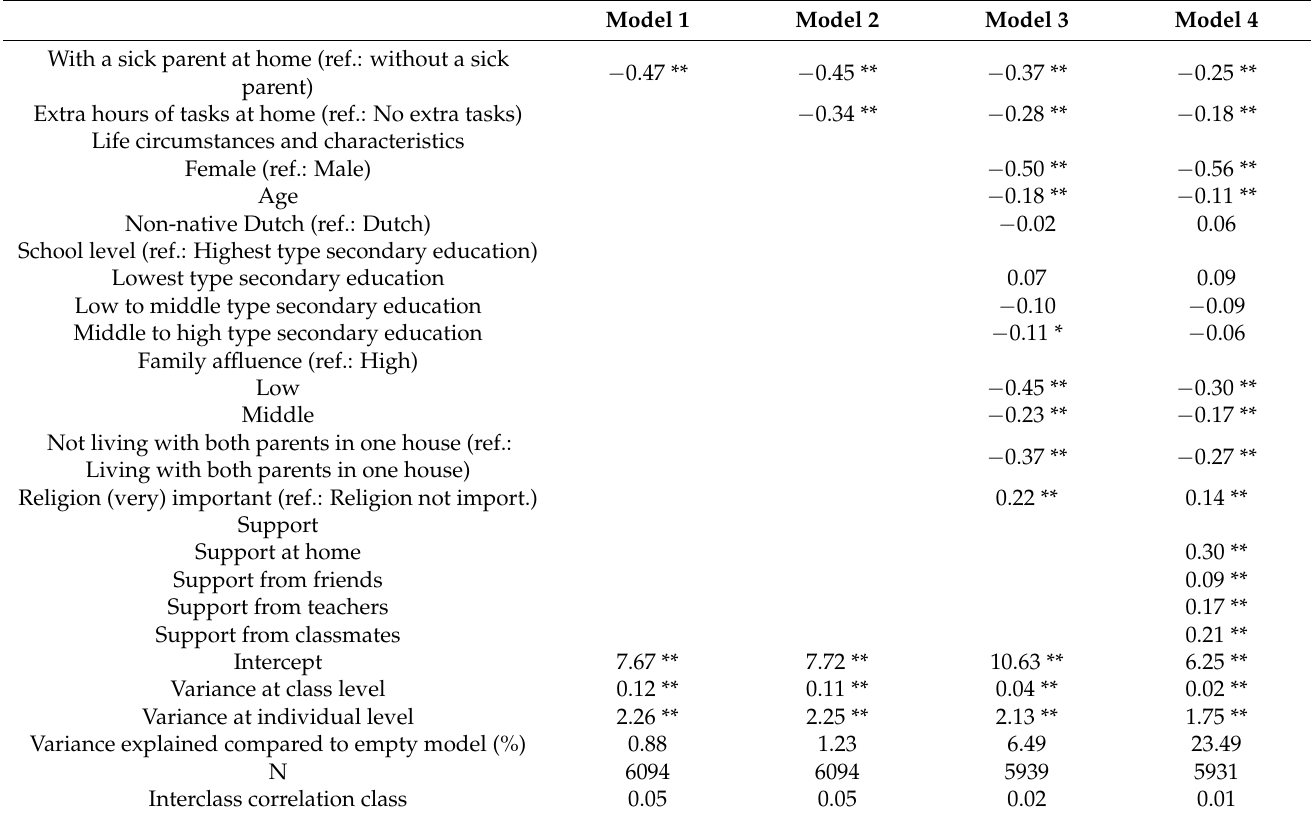
Table 3. Stepwise multilevel regression of having a sick parent at home, extra hours of tasks at home, life circumstances and characteristics, and social support on life satisfaction of schoolchildren aged between 12 and 16 (unstandardised coefficients, n =